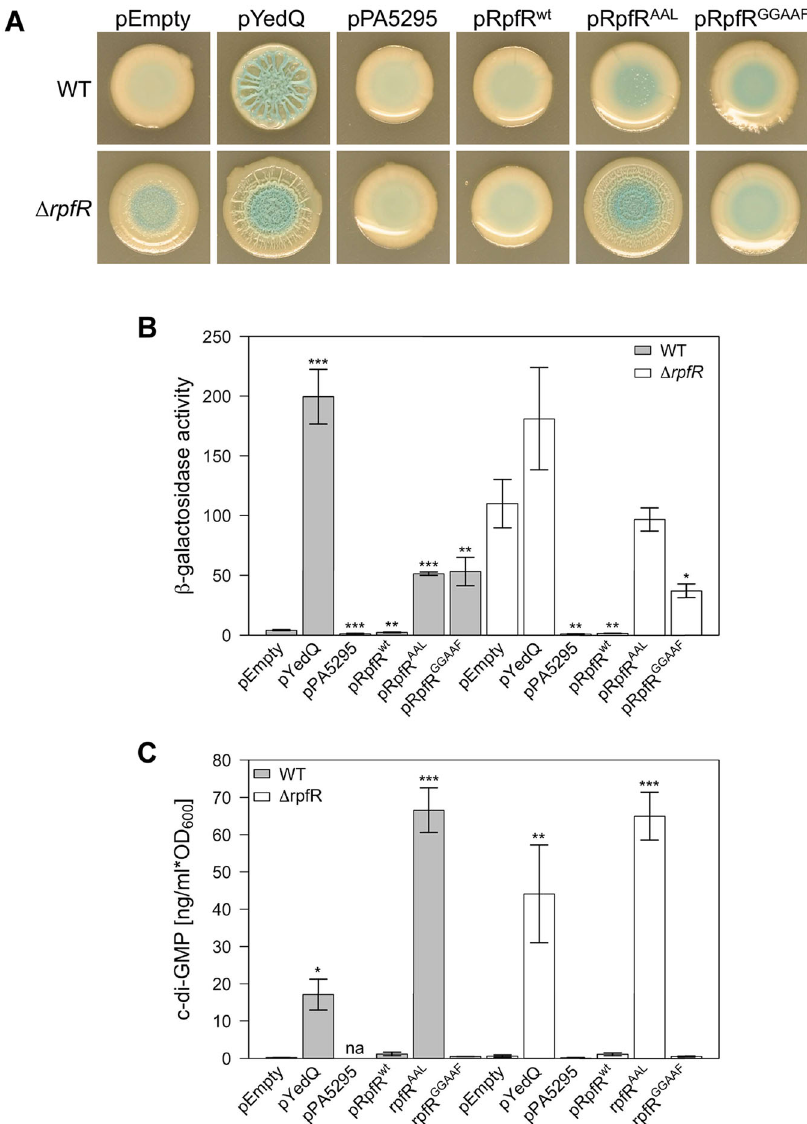
Fig. 5 Effect of arti fi cially modi fi ed intracellular c-di-GMP levels on Bep expression. Expression vectors for modifying c-di-GMP levels were introduced into bepB :: lacZ reporter strains with wild-type or rpfR mutant genetic background. A Colony morphology and β -galactosidase expression after growth for 6 days of the indicated bepB::lacZ reporter strains on NYG agar plates supplemented with X-gal. B Quanti fi cation of β -galactosidase activity (Miller units) of the indicated bepB::lacZ reporter strains. The values shown are the means ± standard errors of the means (SEM) of 6 measurements (3 independent experiments and 2 technical replicates per strain). C Quanti fi cation of intracellular c-di-GMP concentrations. The values shown are the means ± SEM of 2 independent experiments. The signi fi cance levels, as determined using a one-way ANOVA, of the difference between the strains carrying the empty vector and the strains carrying the indicated expression vectors are indicated above the bars; *** P < 0.001; ** P < 0.01; * P < 0.05; no stars indicate no signi fi cant difference; na, value below the detection